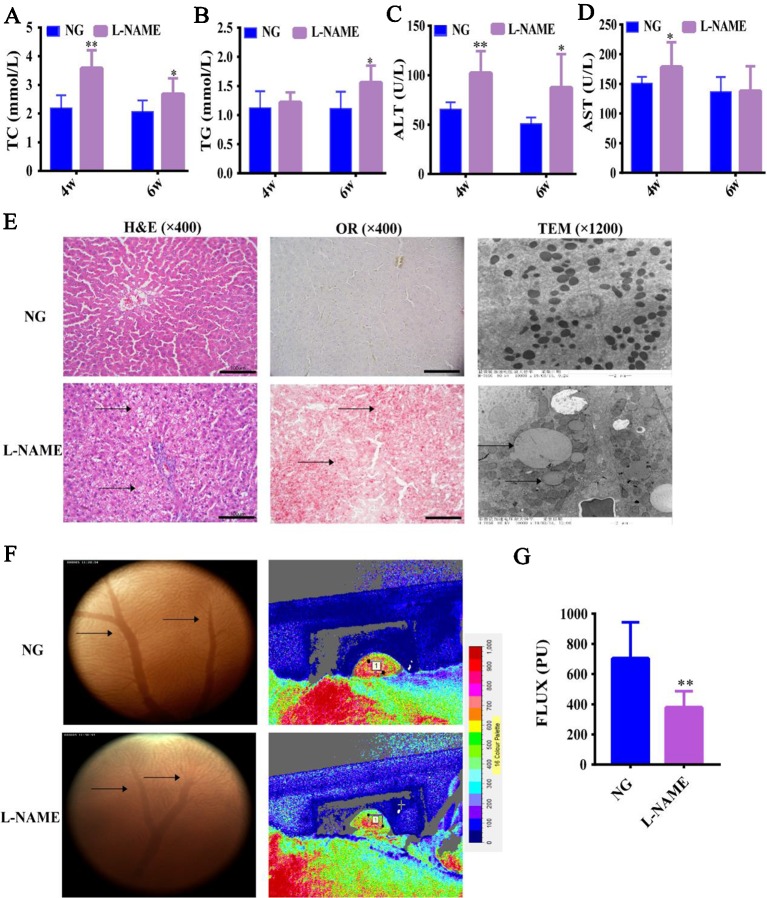
Changes of serum lipid profiles, liver function, and hepatic histopathology in the L-NAME-treated rats. (A) Changes of serum TC. (B) Changes of serum TG. (C) Changes of serum AST. (D) Changes of serum ALT. (E) Representative photomicrograph of histological alterations in the liver by H&E staining (×400), Oil red O staining (×400), and transmission electron microscopy (×1,200) (the arrows indicate the lipid accumulation in the liver). (F) Changes of gross microcirculation and hepatic microcirculation (the arrows indicate the microvessels in the liver). (G) The gross microcirculation perfusion. Bar = 100 μm. The data were expressed as means ± SEM. Significant differences are indicated by *P < 0.05, **P < 0.01 as compared with the NG (n = 9 per group).